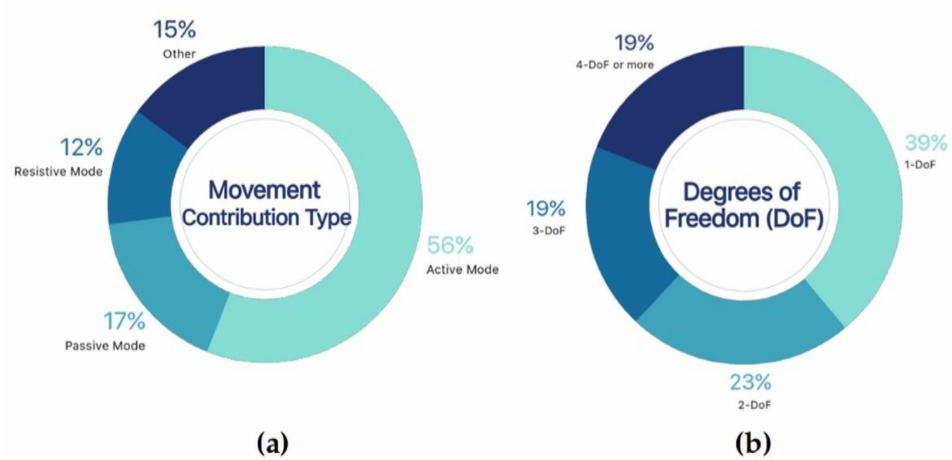
Figure 6. The distribution of the operating modes of robotic exoskeletons in terms of ( a ) movement contribution types and ( b ) total degrees-of-freedom